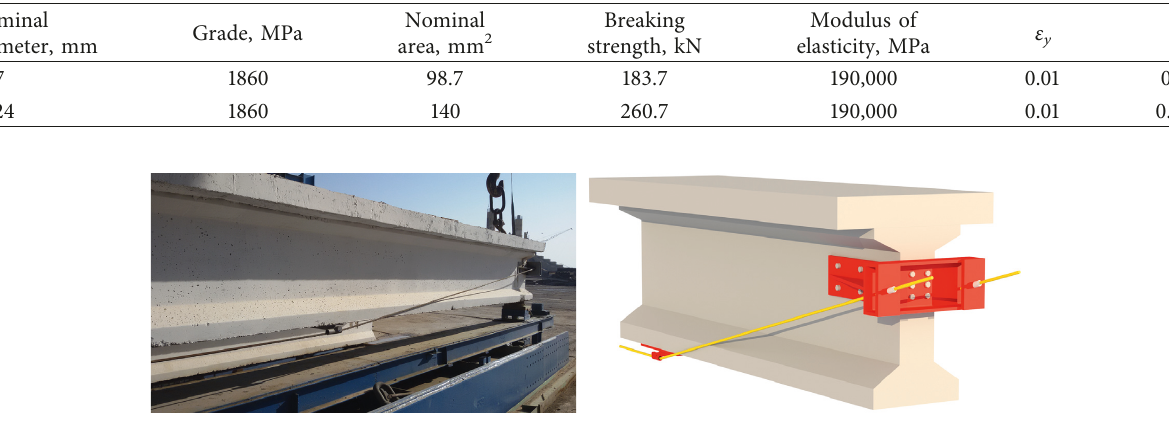
Figure 2: External prestressing scheme for